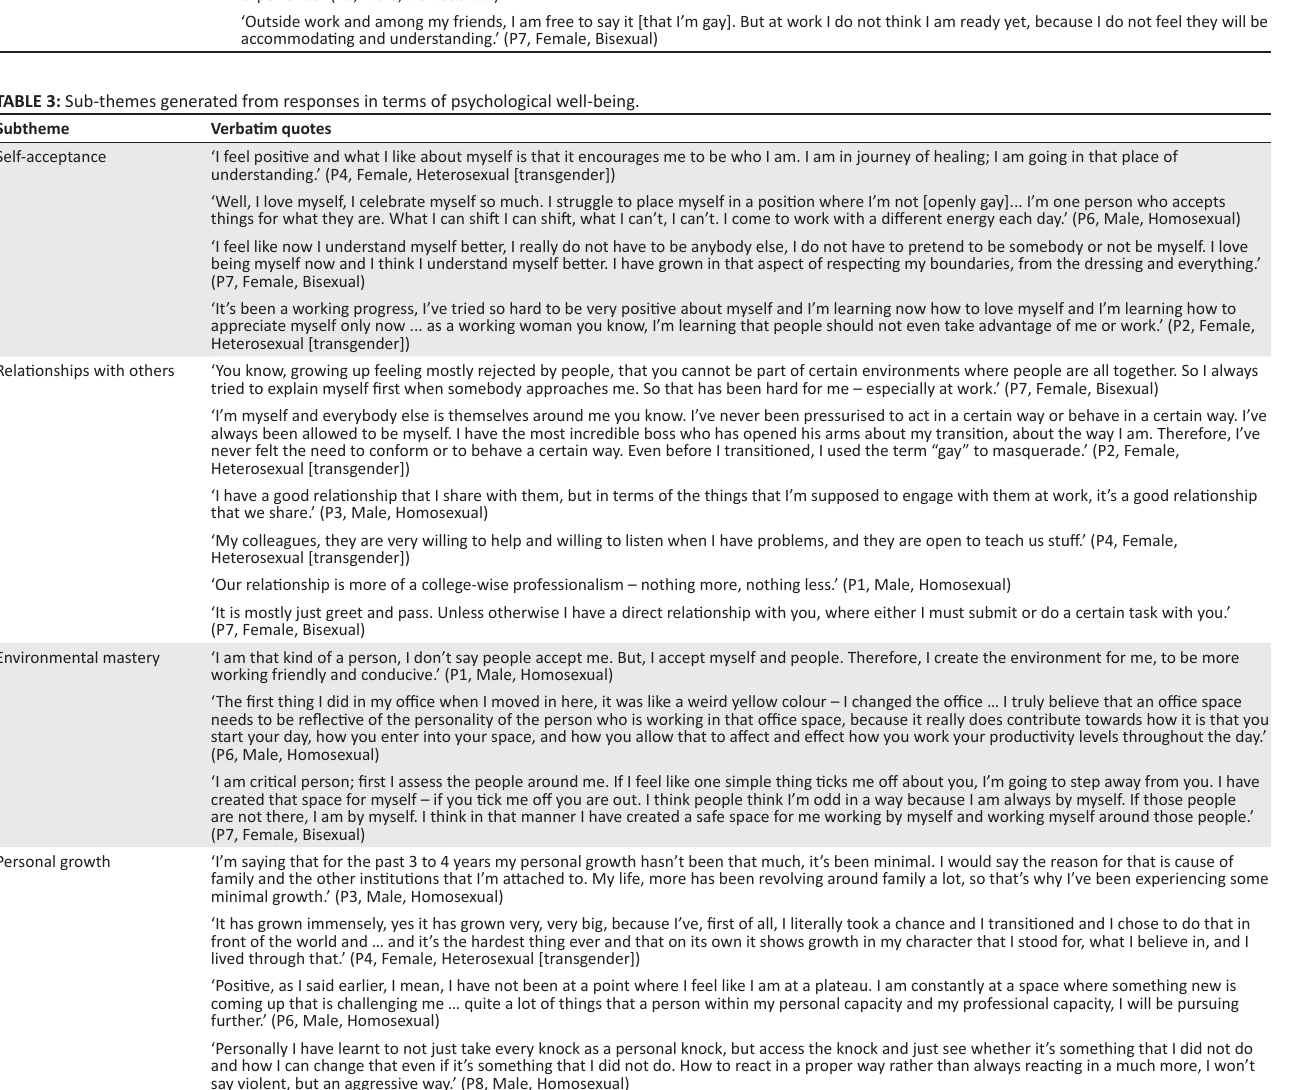
TABLE 3: Sub-themes generated from responses in terms of psychological well-being.